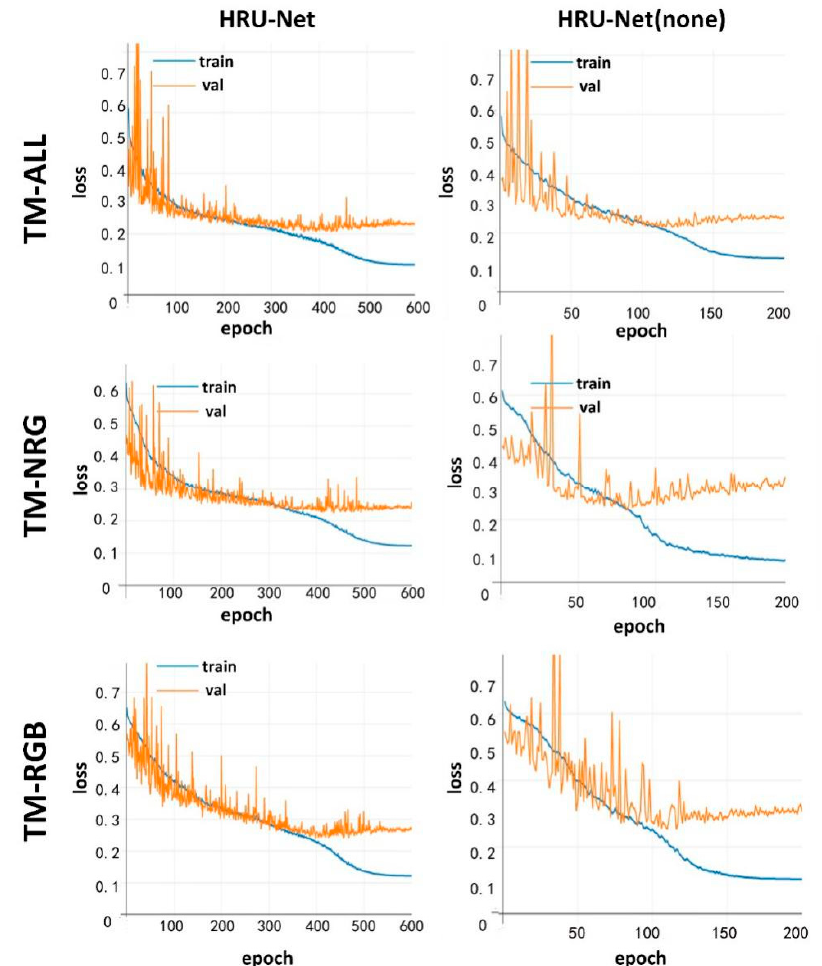
Figure 9. Visualization of the training history for the HRU-Net. HRU-Net (none) represents the HRU-Net without the modification of the loss function. Table 8. Comparison of the HRU-Net with or without the modified loss function.